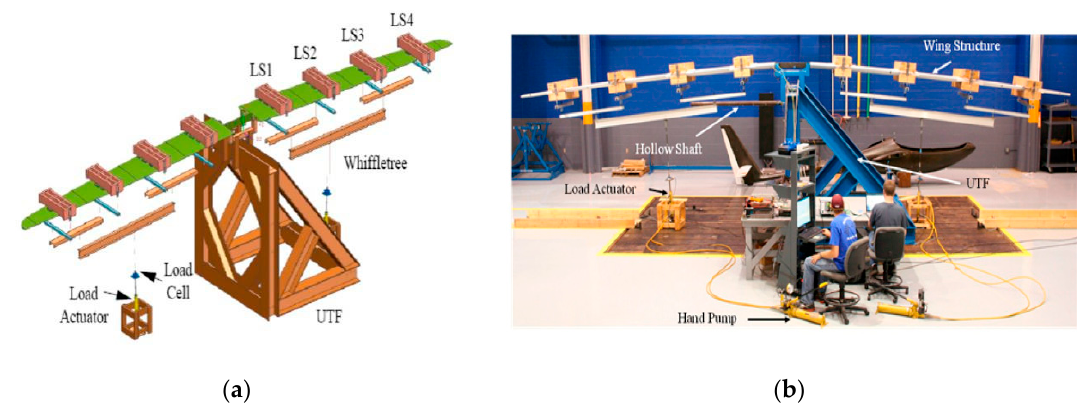
Figure 24. ( a ) Sketch of test for concentrated and distributed loading with the wing loading stations; ( b ) Photo of wing structure under whiffletre loading ( b ) Photo of wing structure under whiffletre loading [90].